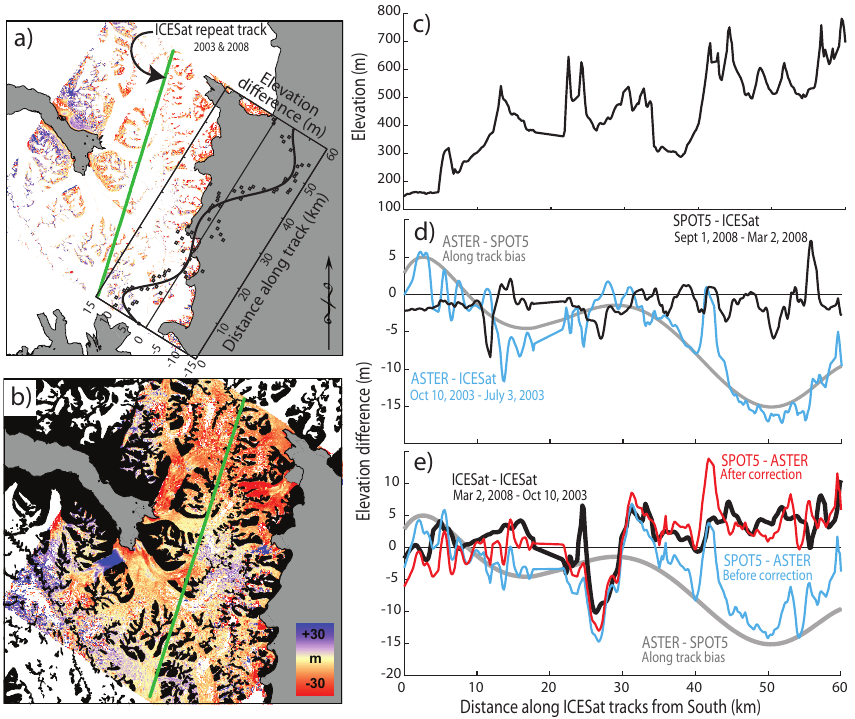
Fig. 10. Elevation differences between the SPOT5-HRS and ASTER DEMs over the non-glaciated regions (a) and the glaciated regions (b) . The graph inset in (a) shows the along track bias measured from the stable terrain and the 6th order polynomial correction. The green line is an ICESat repeat track from 10 October 2003 and 2 March 2008. The elevation profile from the 2003 ICESat track is shown in (c) , The differences between DEMs and the ICESat track closest in time to the DEM acquisition is compared (d) . The difference between the ASTER DEM and ICESat is similar to the bias correction as determined between the ASTER and SPOT DEMs. The elevation changes between 2008 and 2003 are shown in (e) before and after correcting for the along track ASTER bias. ICESat to ICESat differences are made by a simple along track interpolation as the cross track separation was not greater than 15m, which is well within the footprint size of ICESat.